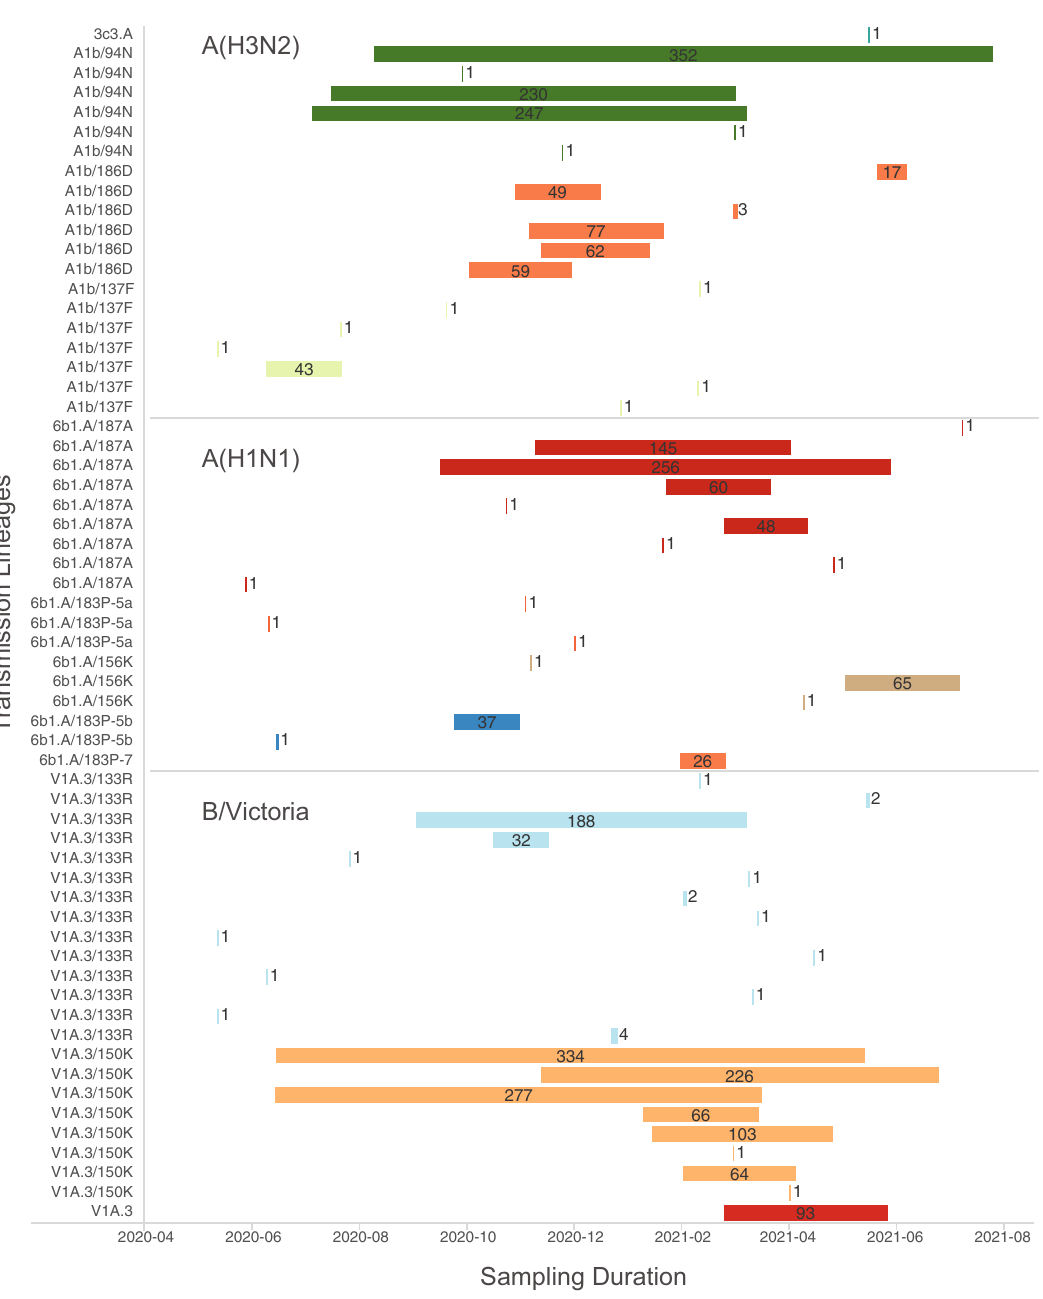
Fig. 5 Cluster size and duration of in fl uenza transmission lineages that originated before the COVID-19 pandemic. Each colored bar represents a monophyletic transmission lineage inferred from maximum-likelihood phylogenetic analyses of seasonal in fl uenza HA gene sequences in GISAID (see Online Methods section). Labels indicate sequence counts per transmission